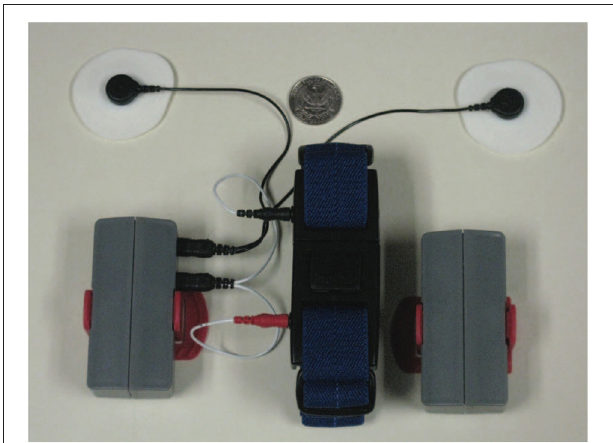
FIGURE 7 | AutoSense sensor suite including ECG leads and RIP connectors plug in to the unit on the side. The red clip in the wearable packaging is used to attach the unit to the (blue) RIP band that goes around the chest [Modified from Ertin et al., SenSys , 2011(